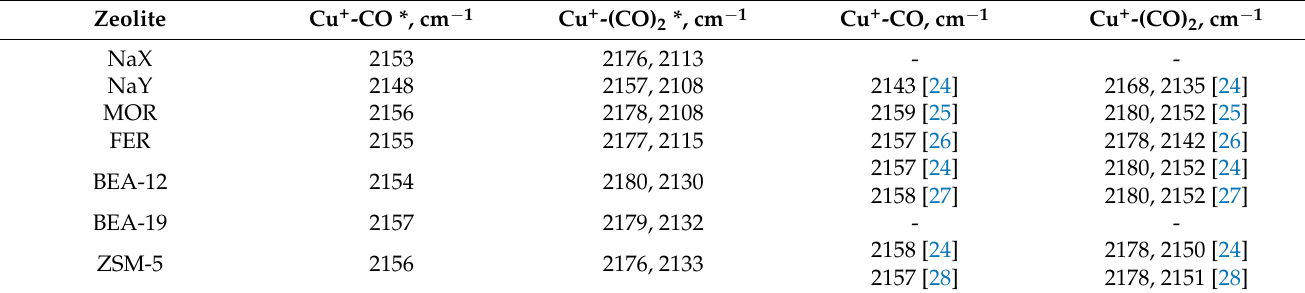
Table 2. FTIR bands of CO adsorbed on Cu-impregnated zeolites (* data obtained in this work).